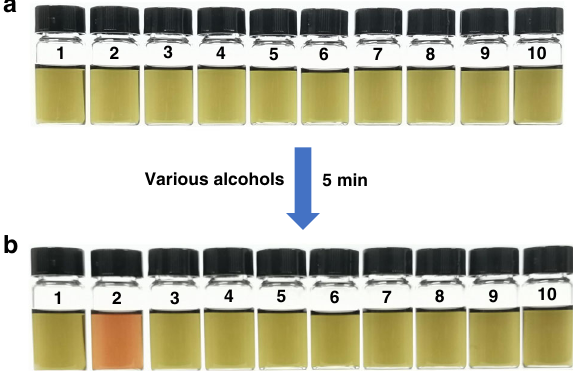
Fig. 8 Photographs of the D solutions in response to various alcohols. a Vials containing D (1.3 × 10 − 5 mol/L) and NaOH (s) (10 mg) in THF (3.0 mL). b The same vials as in a after adding 3.0 μ L of the following alcohols (from left to right and numbered 1 – 10 ): none, methanol, ethanol, 1-propanol, 2-propanol, 1-butanol, 2-butanol, phenylcarbinol, ethylene glycol, and glycerol, respectively.